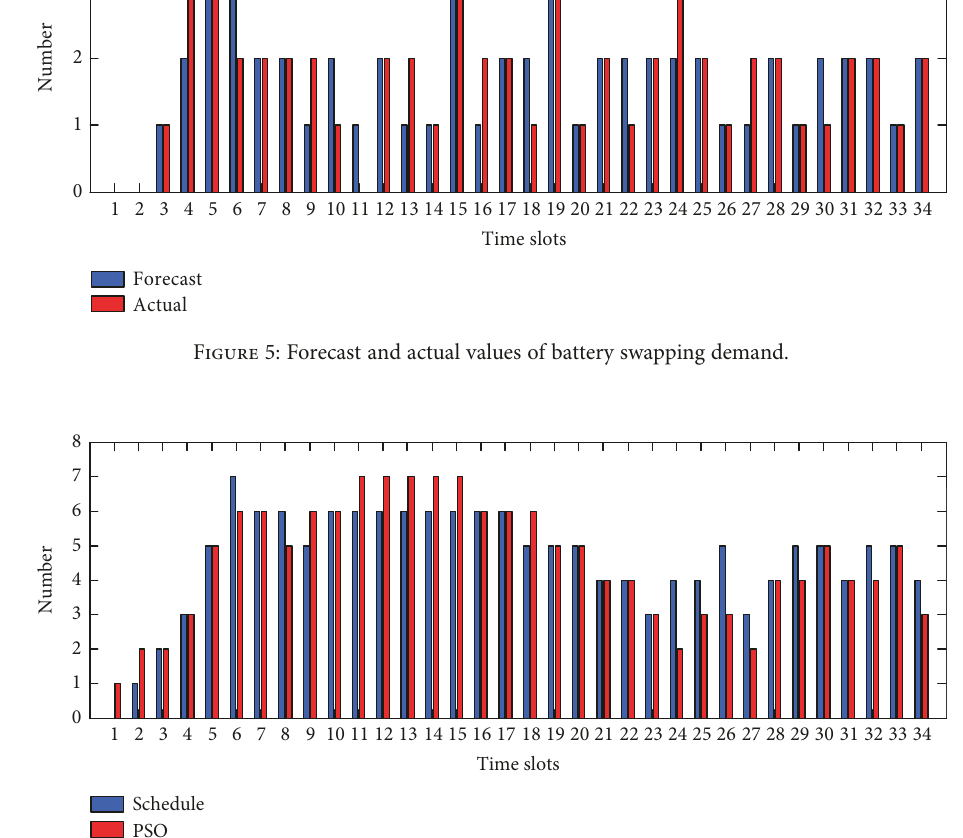
Figure 6: The number of batteries charged using the schedule and PSO strategies.